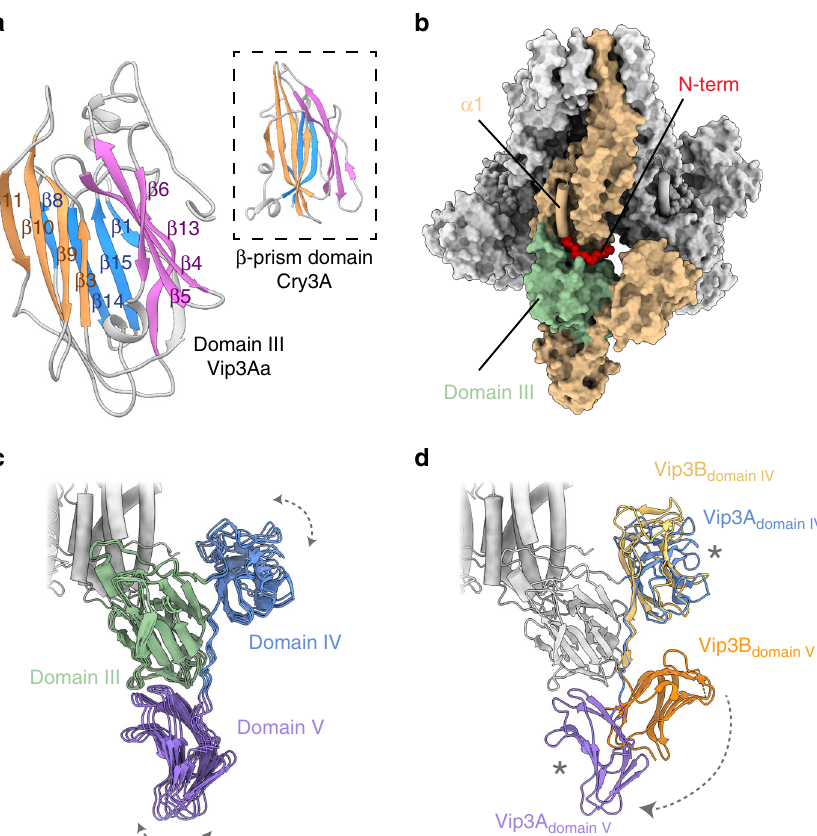
Fig. 2 The fl exible C-terminal domains contain motifs found in other toxins. a Domain III forms a β -prism fold similar to that found in the Cry toxins. b The N-terminal region of the four monomers (red) is inserted into a groove formed between domain III (green) and the core of the particle. c Superposition of domains III, IV and V, docked into the three most distant positions found in the focused 3D classi fi cation, shows the fl exibility of these domains in the Vip3Aa reconstruction. d Although the comparison with the Vip3B protoxin (PDB ID 6V1V) reveals a similar overall architecture, the orientation of domain V is markedly different to that found in Vip3Aa. The putative sugar binding site at domain IV and V is labeled as an